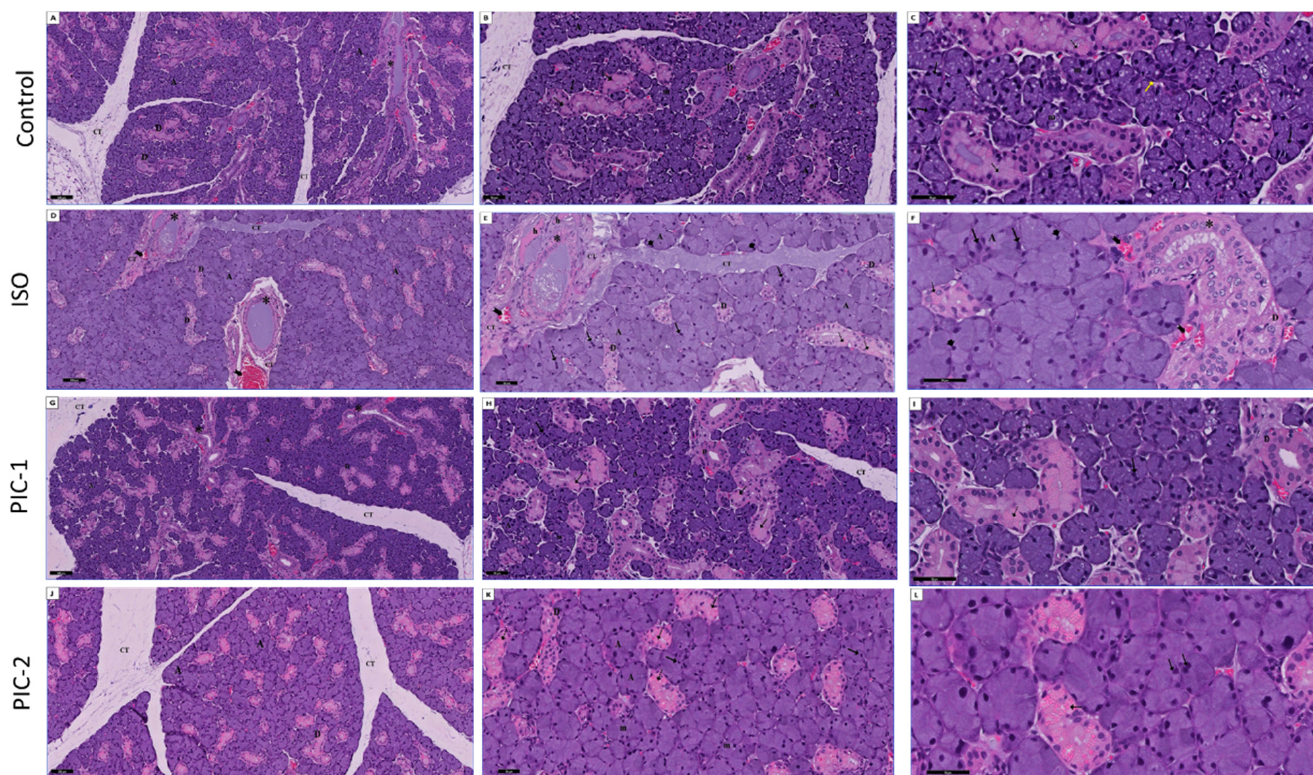
Figure 4. A section in the submandibular gland stained with HE from the control group ( A – C ) showing numerous lobules separated by thin connective tissue septa (CT). The lobules show closely packed mixed secretory acini (A), granular convoluted tubules (D) and execratory ducts (*). The acinar cells are mixtures of serous ( ↑ ) and mucous (m) secretory cells. The myoepithelial cells (yellow arrow) appear gasping the acini. The striated ducts are lined by columnar cells having oval nuclei (D). The well-developed granular convoluted duct is lined by columnar cells having eosinophilic cytoplasm (dot arrow). The excretory ducts (*) have tall columnar epithelium with more apically located nuclei and prominent cytoplasmic striations. (HE; A × 100, B × 200, C × 400). ISO group ( D – F ) showing markedly hypertrophic packed secretory acini (A). The normal architecture of acinar cells is distorted, their nuclei became dark and deeply stained atrophied nuclei (arrowhead). The cytoplasm lost its basophilic character (A). Giant nuclei ( ↑ ) are also seen. The cytoplasmic vacuolation in ductal (D) cells were increased with reduced acidophilic content of the cytoplasm of granular duct cells (dot arrow). Execratory ducts (*) appear with loss of pseudo-stratification and stagnated secretion in the lumen. The duct was surrounded by dens fibrous connective tissue (CT) with hyalinization area (h) and congested dilated blood vessels (bifid arrow). (HE; D × 100, E × 200, F × 400). Low dose of PIC (PIC-1 group) ( G – I ) showing marked improvement in the histological structure of cells of acini (A) as well as cells of ducts lining, and the acini relatively preserve their shape are seen. The numbers of vacuoles decrease, and well-formed striated ducts (D) are also detected. The granular convoluted tubules were lined by simple columnar epithelium with eosinophilic cytoplasm and basal rounded nuclei. (HE; G × 100, H × 200, I × 400). High dose of PIC (PIC-2 group) ( J – L ) showing marked improvement in the histological structure. The submandibular gland appears nearly as the control group. (HE; J × 100, K × 200, L × 40).